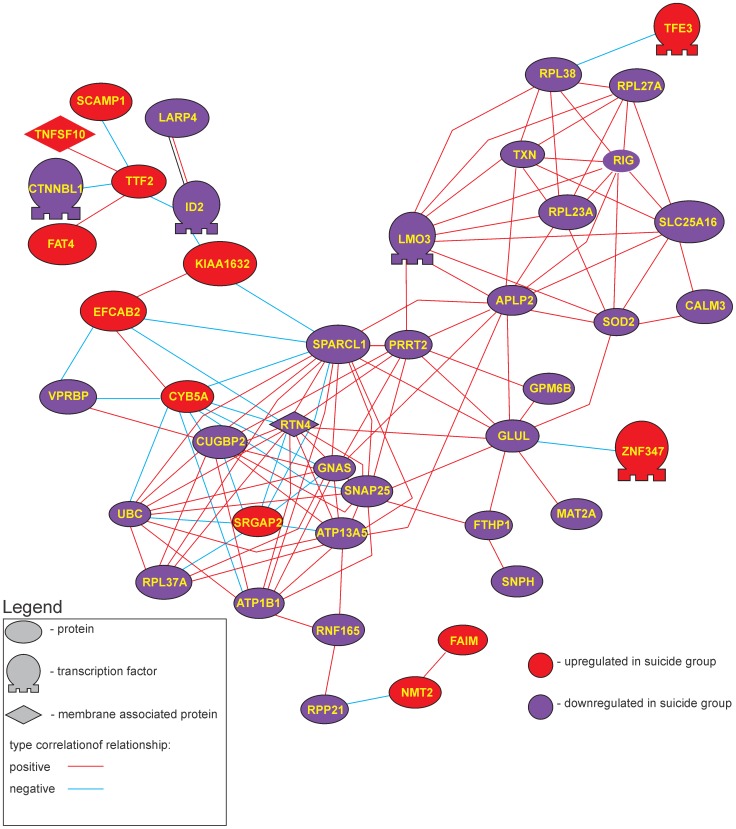
Coordinated gene expression is greatly reduced in suicide/MDD cohort.Pearson’s correlation-based gene network for differentially expressed genes for depressed suicide class. Red nodes represent genes up-regulated in depressed suicide class, blue nodes represent genes down-regulated in depressed suicide class, graphs - correlation of gene expression. Network contains 21 genes connected by 80 correlation relationships higher than 0.8.